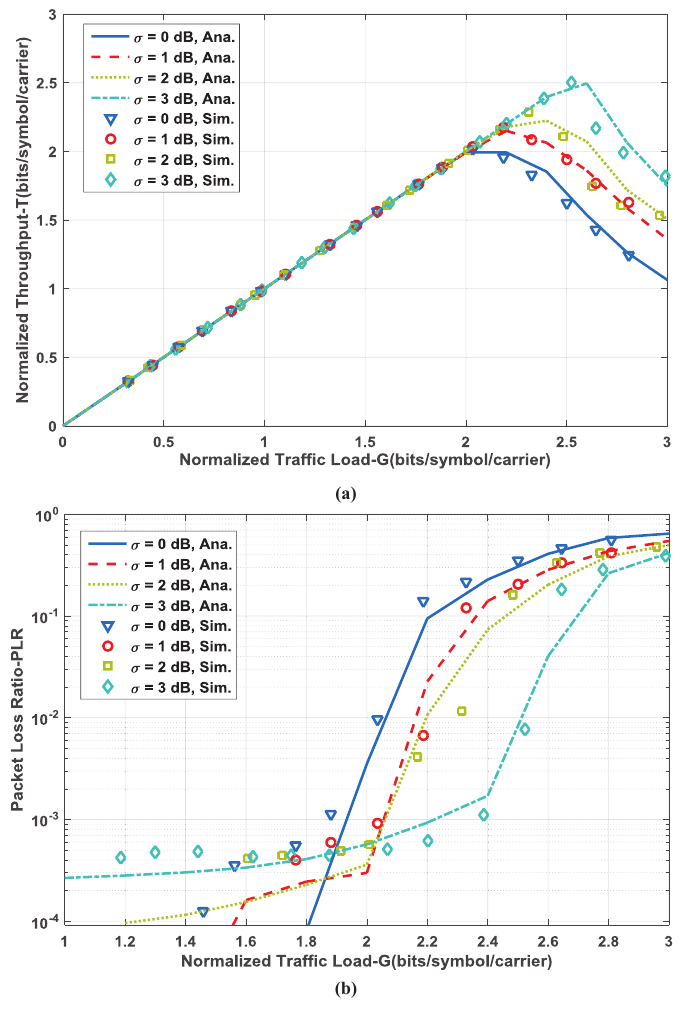
Figure 3. AF-SCMA analytical and simulation results comparisons for packet size 500 bits, Turbo encoder with r = 1/3, SCMA (4, 6), [ E b / N 0 ] power unbalance with µ = 0 and σ = 0,1,2,3 dB respectively. ( a ) Throughput. ( b )